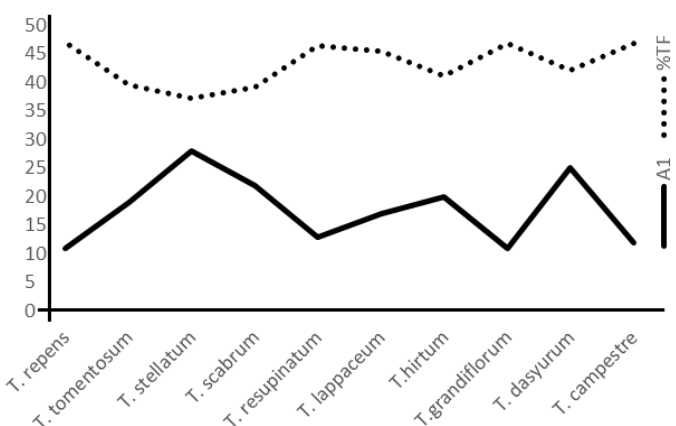
Fig. 3. Intrachromosome asymmetry index and total form percentage trend in different Trifolium species.